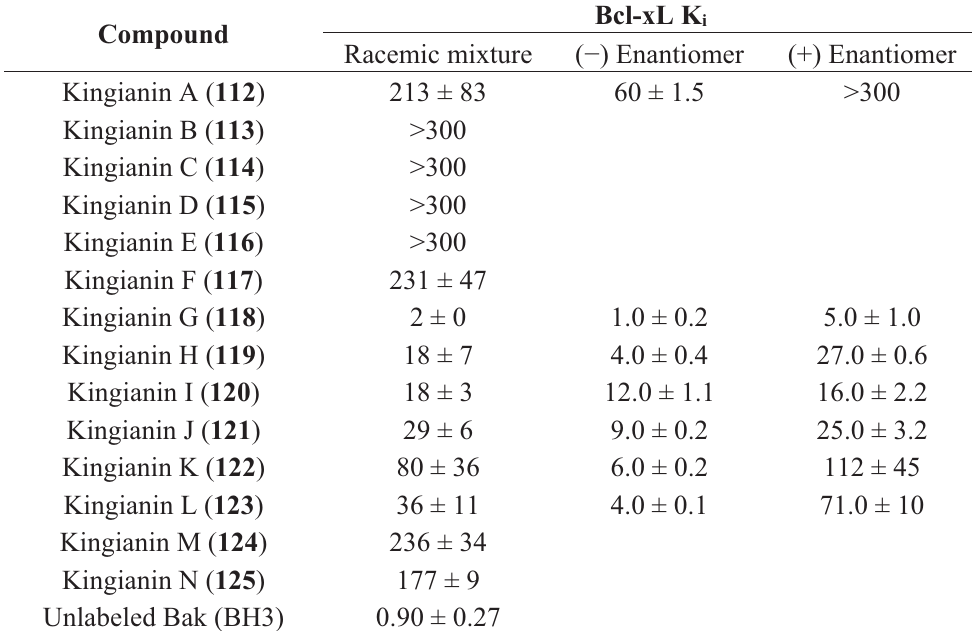
Table 6. Bcl-xL binding affinity of compounds 112 – 125 (K i in (cid:9)M).